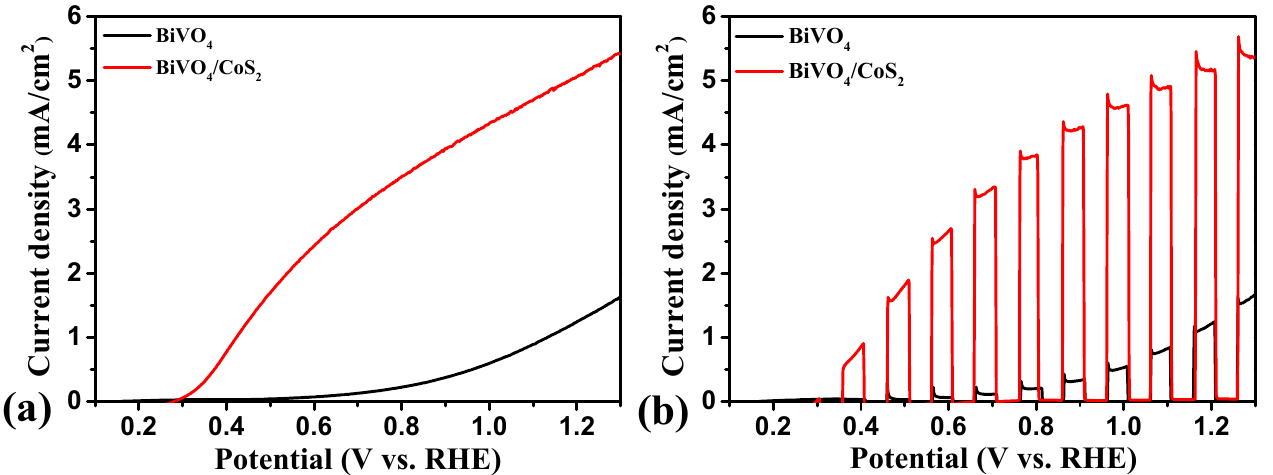
Figure 3. J–V curves of the bare BiVO 4 and BiVO 4 /CoS 2 photoanodes measured under ( a ) continuous and ( b ) chopped AM 1.5G illumination; 0.5 M KPi buffer solution (pH = 7) was used as the